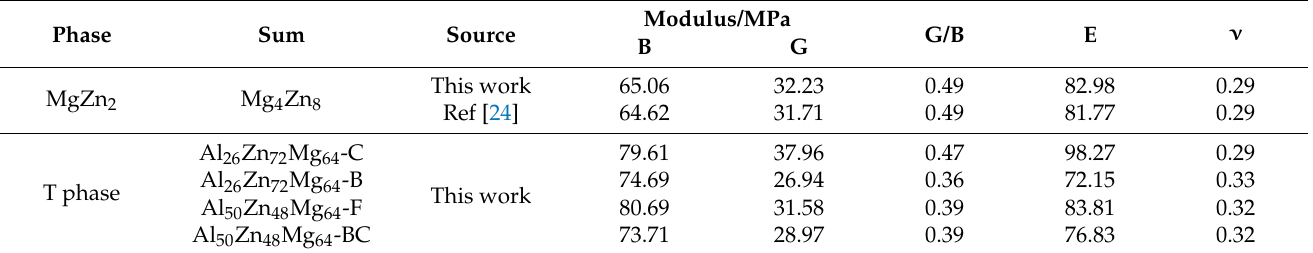
Table 4. Bulk modulus B (GPa), Shear modulus G (GPa), Young’s modulus E (GPa), Poisson’s ratio ν and B/G of MgZn 2 and T